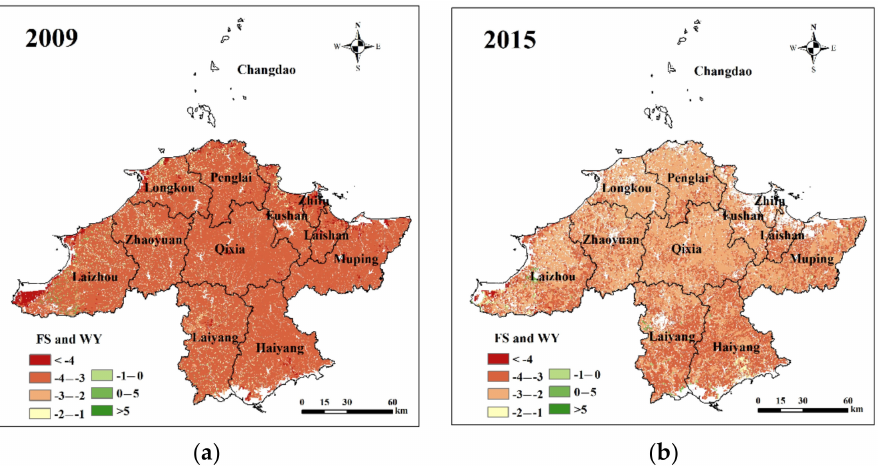
Figure 8. ( a ) Spatial synergies between food supply and water yield services in 2009; ( b ) spatial synergies between food supply and water yield services in 2015.